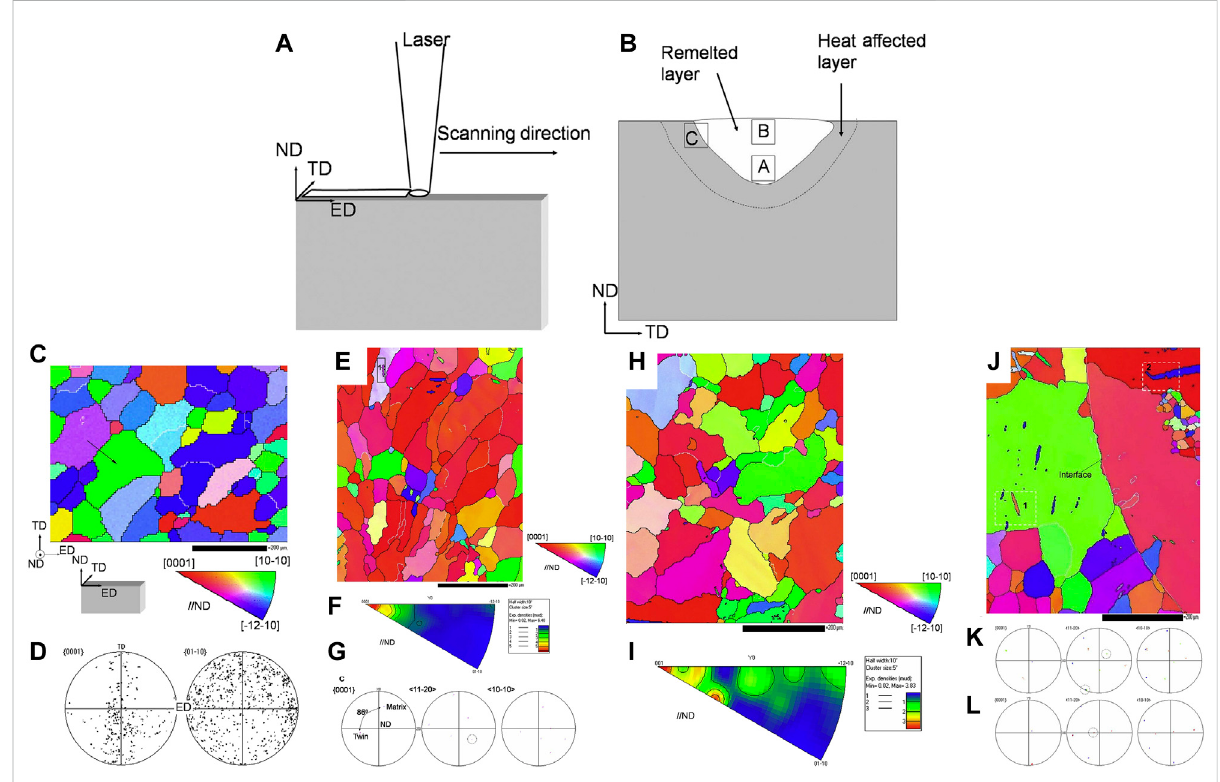
FIGURE 2 (A) The schematic of laser surface treatment and (B) selected areas on the cross section analyzed by EBSD; (C) a typical EBSD orientation map and (D) {0001} and {10 – 10} pole images of the initial sample; (E) EBSD OIM map of the bottom of laser melted layer, (F) the corresponding inverse pole fi gure,and (G) {0001}, < 11 – 20 > and < 10 – 10 > stereographicpole fi gurescorrespondingtoareaonein (E) ; (H) EBSDOIMmapofthetopoflaser melted layer and (I) the corresponding inverse pole fi gure; (J) EBSD OIM map taken at the melt/substrate interface and